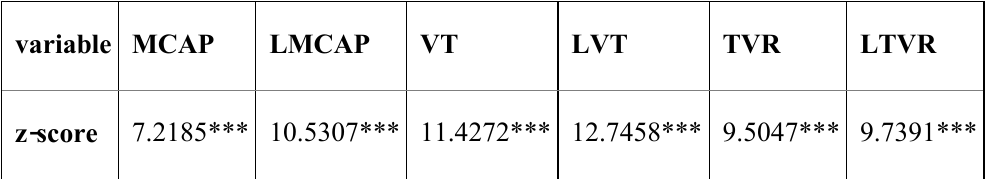
Table7. mean of the stock market variables in developed vs non-developed